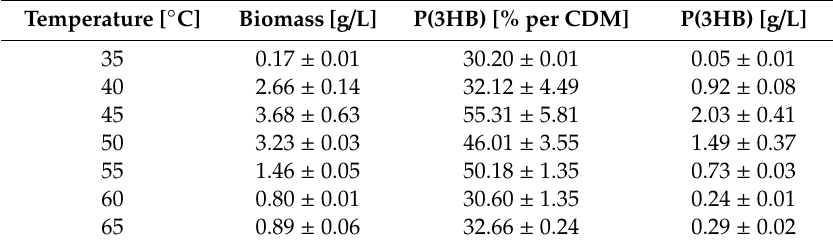
Table 3. E ff ect of cultivation temperature on PHA yields obtained by Aneurinibacillus sp.